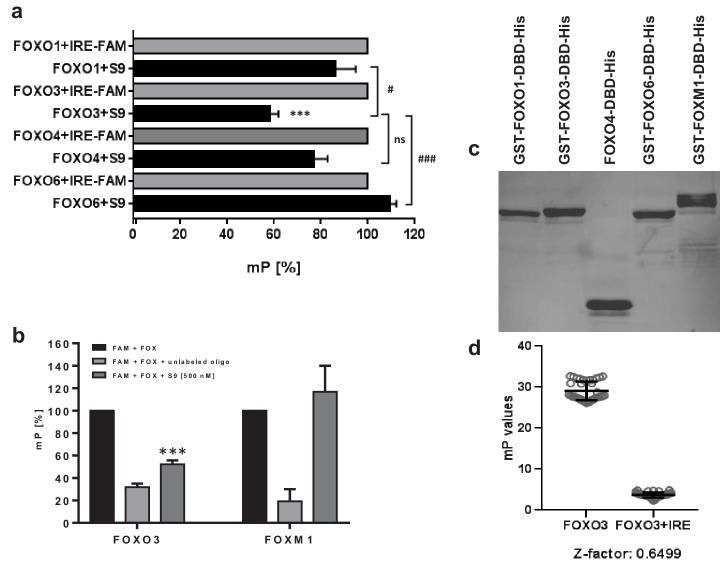
Effect of S9 on protein-DNA interaction of different FOX family members.Recombinant FOXO1-DBD (159 - 272) FOXO4-DBD (82-207) and FOXO6-DBD (87 - 200) were prepared as described for FOXO3-DBD in Materials and methods. FPAs to measure binding of FAM-labeled IRE oligonucleotide (25 nM) to recombinant FOXO1-DBD, FOXO3-DBD, FOXO4-DBD and FOXO6-DBD (each 125 nM) were performed as described. A final concentration of 250 nM of S9 was used for all FOXO proteins. mP value of freely rotating IRE-FAM oligonucleotide was subtracted and the mP-value of FOXO-protein + IRE-FAM oligonucleotide complex was calculated as 100%. Shown is the mean + SEM of three independent experiments, statistical differences between FOXO3 +/- S9 or between FOXO1+S9 versus FOXO3+S9 or FOXO3+S9 versus FOXO6+S9 were assessed with unpaired student’s t-test. FOXO3 +/- S9: ***p<0.001, FOXO1+S9 versus FOXO3+S9: # p<0.05, two-tailed, FOXO6+S9 versus FOXO3+S9: ### p<0.001, two-tailed, (a). An FPA using recombinant FOXM1-DBD (222-360) with the FAM-labeled oligonucleotide TTT GTT TAT TTG TTT GTT TAT TTG was established to test efficacy of S9 on the DBD of this non-FOXO family protein. FPAs of FOXO3 (with IRE-FAM oligonucleotide) and FOXM1 were performed in parallel with a concentration of 500 nM S9 (b) controls were 100fold excess of unlabeled oligonucleotide. Whereas S9 inhibitory effect on FOXO3-DBD FPA was clearly visible, no effect was observed on FOXM1-DBD FPA suggesting that S9 does not interfere with FOXM1-DBD – DNA interaction. Shown is the mean of three independent experiments (student`s t test, ***p<0.001). Recombinant FOXO1-DBD, FOXO3-DBD, FOXO4-DBD, FOXO6-DBD and FOXM1-DBD were separated on PAGE and Coomassie-stained (c). 36 FOXO3-DBD FPAs were performed with FOXO3-DBD (125 nM) and FAM-IRE-oligonucleotide (25 nM) in presence or absence of a 100fold excess of unlabeled IRE-oligonucleotide and Z ´factor was calculated using the formula Z ´=1-(3 σ + + 3 σ - )/(μ + -μ - ). μ + , σ + and μ − , σ − are mean values and standard deviations for the high and low controls (+ unlabeled IRE oligonucleotide), respectively. The analysis provided a Z ´factor of 0.6499 which proves that the FPA is reliable for high-throughput screening (Z ´> 0.5).